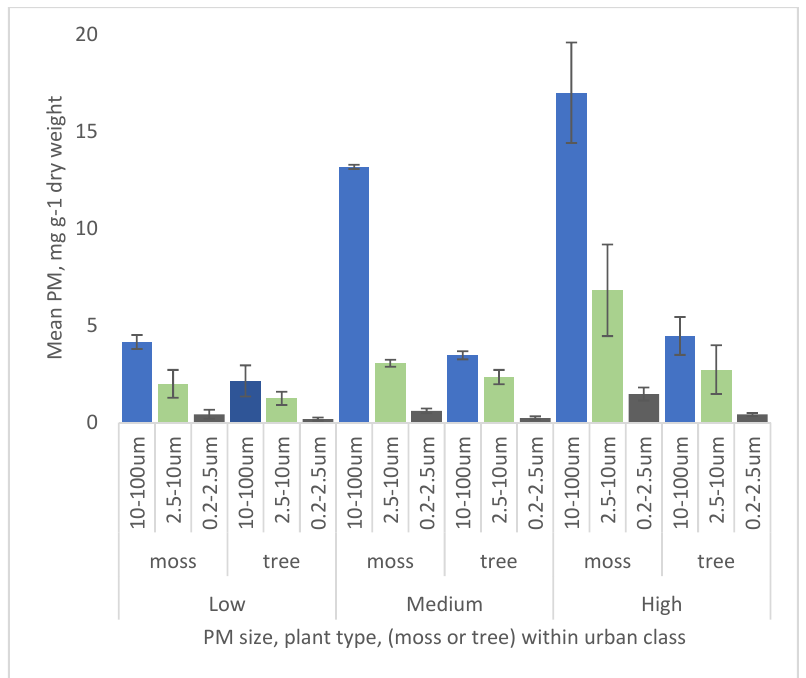
Figure 4. Particulate matter (PM) captured by roadside moss turfs and tree leaf samples at nine sites in three urban classes, “low”, “medium”, and “high”. PM is shown by fraction size, 10–100 µm, 2.5–10 µm, and 0.2–2.5 µm. PM values are expressed as mg per g dry weight. Error bars are ± 1 standard error. Table 1. Summary of main results comparing moss turfs and tree leaves for PM capture, photosynthetic e ffi ciency (F v / F m ), and wax content at nine sites in three urban “classes”: low (quiet roads), medium (suburban roads), and high (freeways) within Wollongong, NSW. PM is shown in mg per g dry weight. PM 100 refers to PM of 10–100 µ m, PM 10 is between 2.5 and 10 µ m, and PM 2.5 is between 0.2 and 2.5 µ m. F v / F m is a ratio and represents the maximum quantum yield of PSII (PSII refers to photosystem II). Wax content is mg per g dry weight. Numbers in brackets show ranges for F v / F m and for wax content.